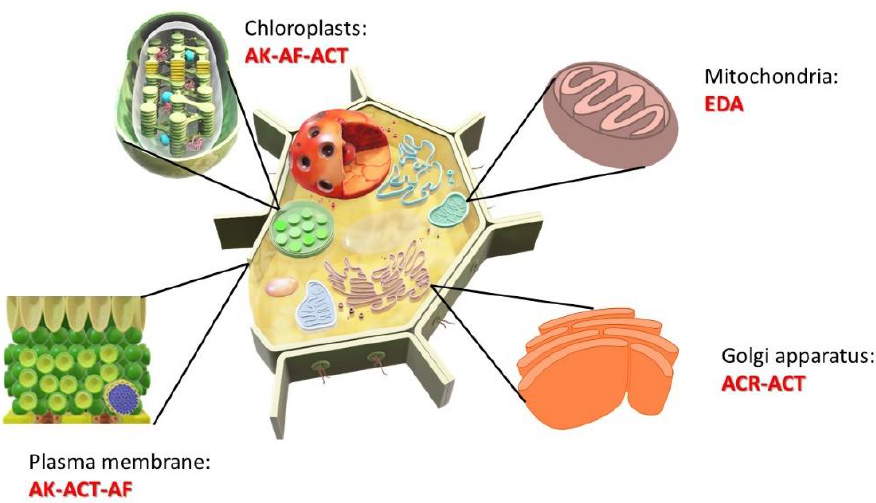
Figure 2. Primary targets (major membranous organelles) of host-specific toxins for cell